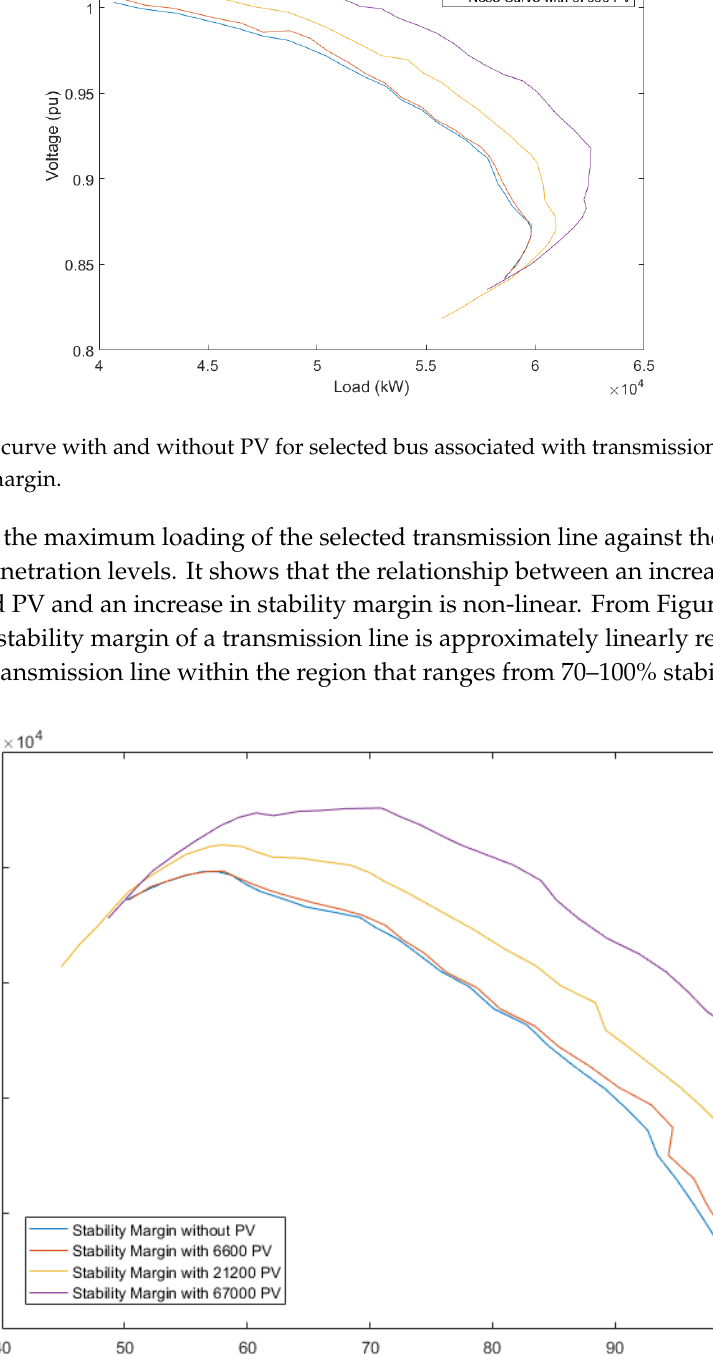
Table 3. Linear regression equations and goodness of fit for all scenarios of Figure 4.